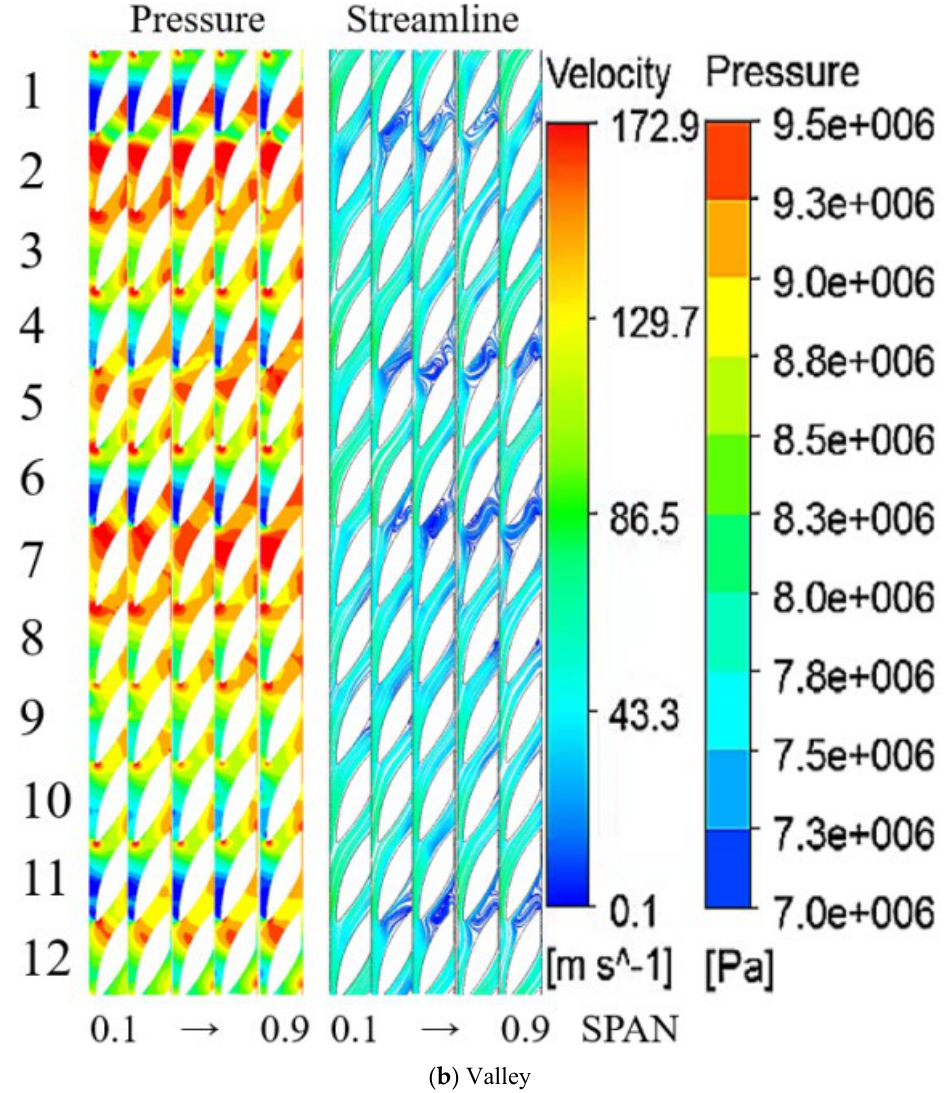
Figure 8. Flow field comparison in diffuser under peak and valley condition. The pressure distribution at the inlet and outlet of the diffuser and the flow pattern in the diffuser are both shown in Figure 9, where the red curve and red dotted line repre- sent the circumferential pressure distribution and average pressure at the diffuser outlet, and the blue curve and blue dotted line correspond to the diffuser inlet. It can be seen from Figure 9 that under the peak condition, the diffuser works well with a smooth flow and regular pressure distribution at the inlet and outlet. Under the valley condition, the pressure distribution uniformity at both the inlet and outlet is destroyed by stall, and the inlet pressure near the flow passage where the stall cell exists increases significantly, marked by Pressure Rise in Figure 9. This is an intuitive manifestation of the blocking and pressurization effect of stall.